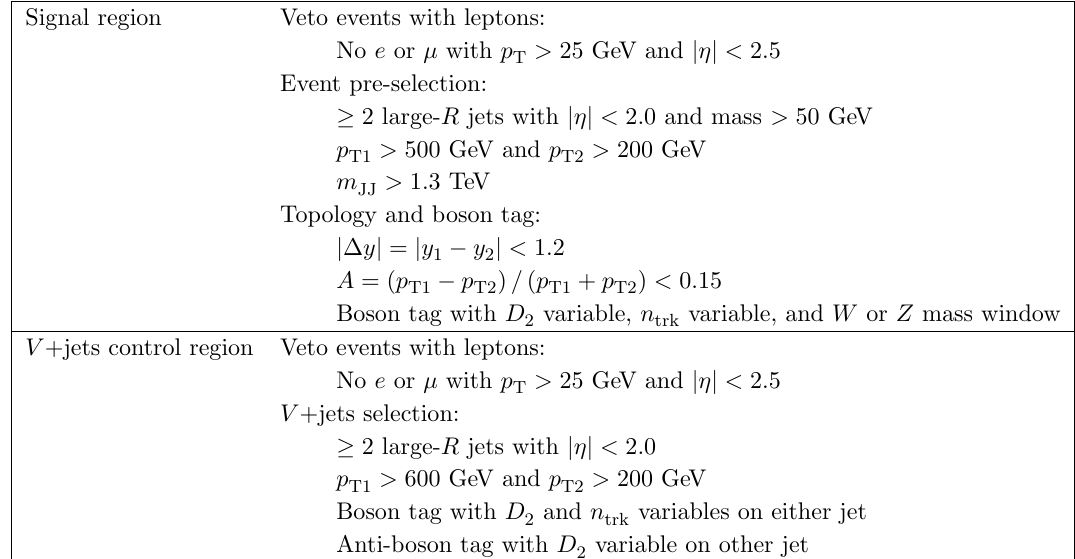
Table 1 . Event selection requirements and de(cid:12)nition of the di(cid:11)erent regions used in the analysis. Di(cid:11)erent requirements are indicated for the highest- p highest- p (subleading) jet with index T